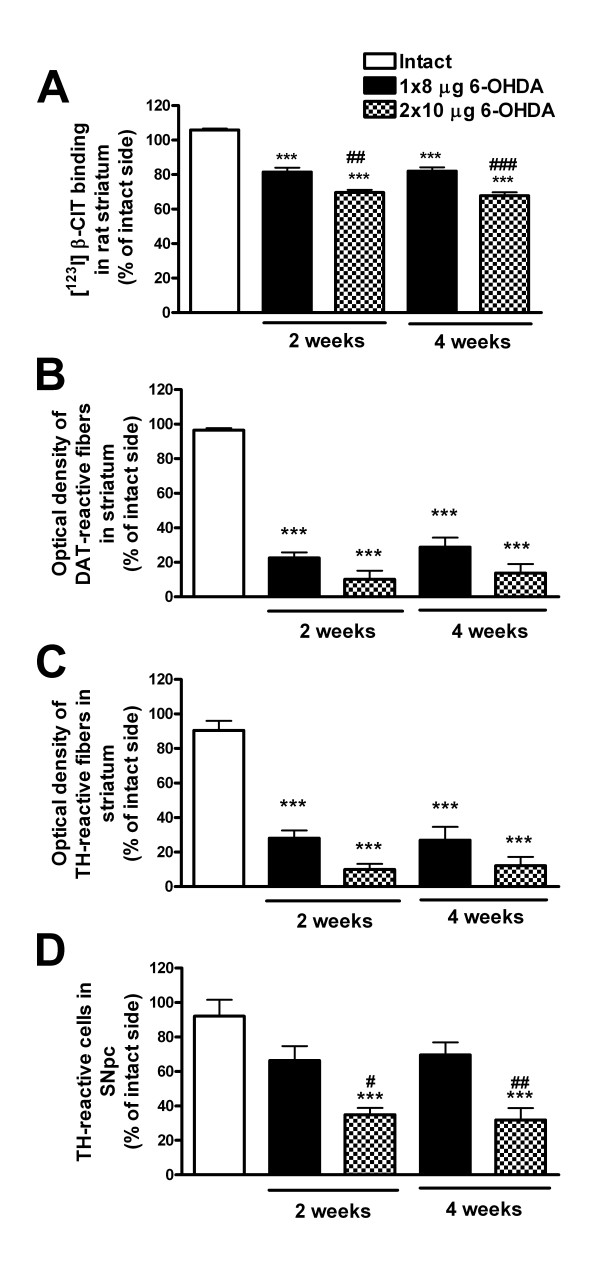
Unilateral 6-OHDA-induced changes in [123I]β-CIT SPECT/CT and immunohistochemical findings. All results are presented as percentage of the lesioned/left side versus the intact/right side. (A) The 6-OHDA injections caused a significant decrease in striatal [123I]β-CIT uptake as compared to intact rats at both 2 and 4 weeks post-lesion. Furthermore, the two different lesions (8 and 2 × 10 μg) could be distinguished with [123I]β-CIT SPECT/CT. Intrastriatal injection of 8 or 2 × 10 μg 6-OHDA resulted in extensive loss of (B) DAT- and (C) TH-immunoreactive fibers in the striatum, but there was no significant difference between the two lesion groups. However, when counting (D) TH-reactive cells in the substantia nigra pars compacta, the cell loss significantly differed between the lesion types. All results are shown as mean ± SEM. ***P < 0.001 as compared to intact rats; #P < 0.05, ##P < 0.01, and ###P < 0.001 as compared to 8-μg 6-OHDA lesion group (one-way ANOVA followed by Tukey post hoc test, n = 4 to 5 per group).